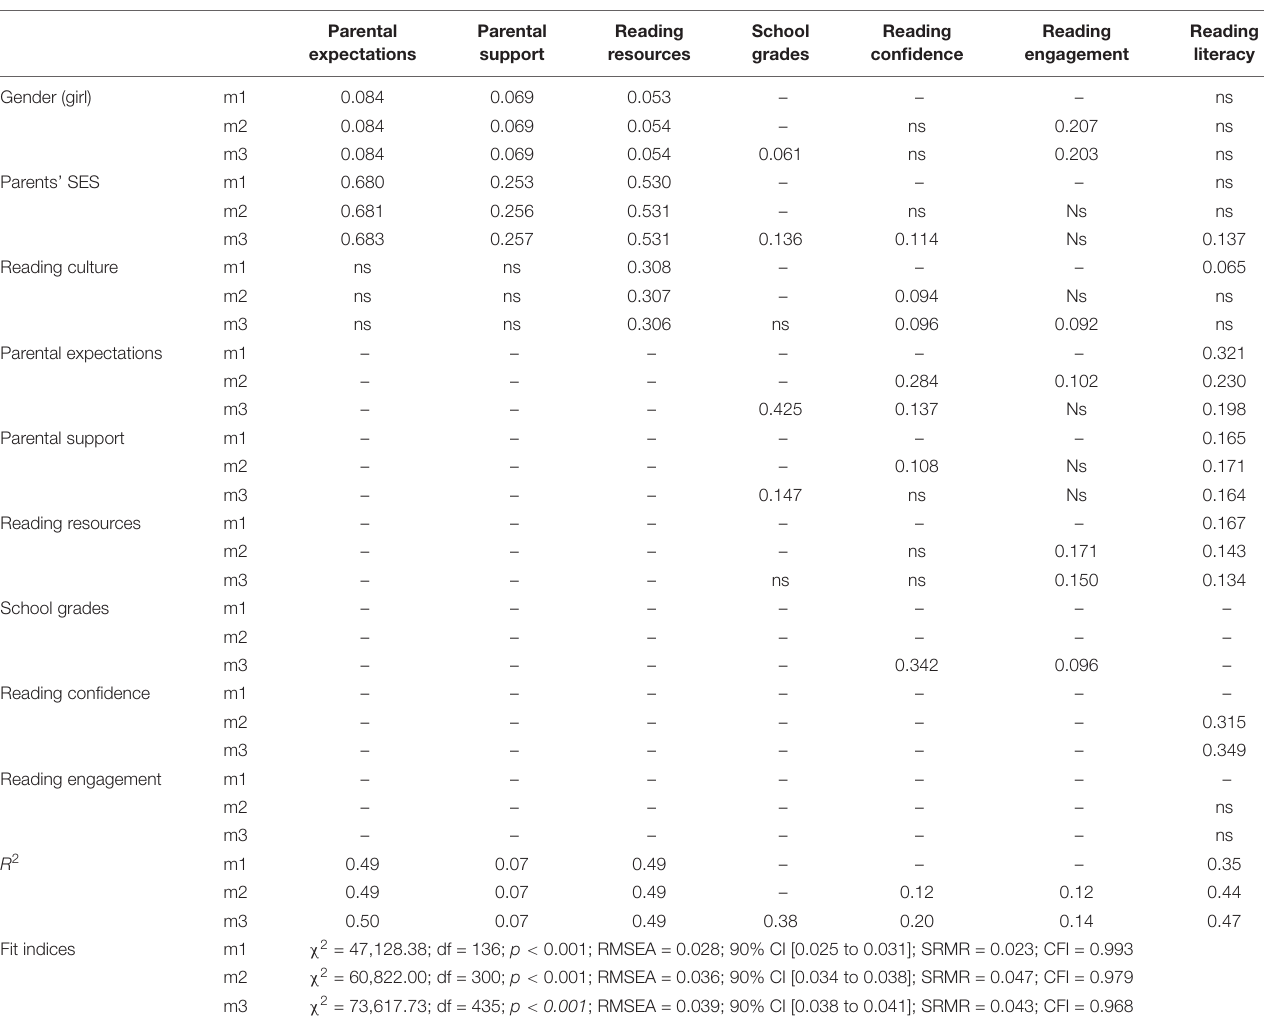
TABLE 3 | Parameters included in the